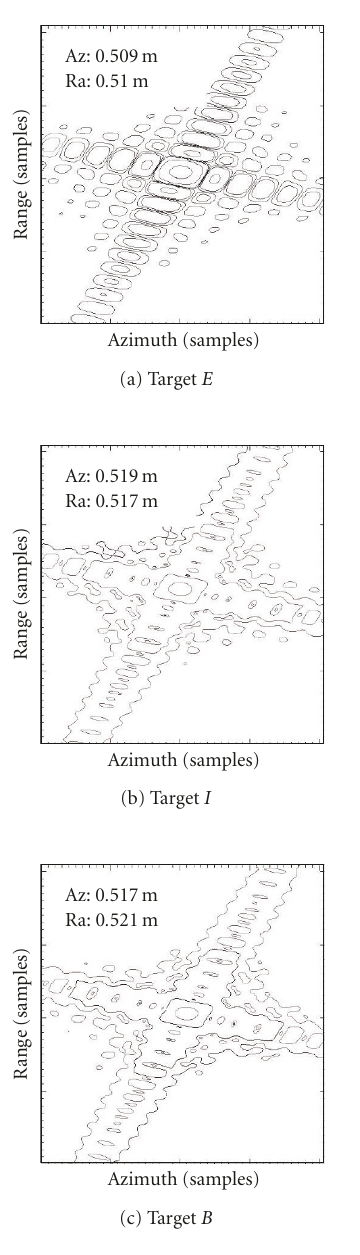
Figure 5: Resolution analysis after processing with the modified ( ω , k )-algorithm (squint angle = 20 ◦